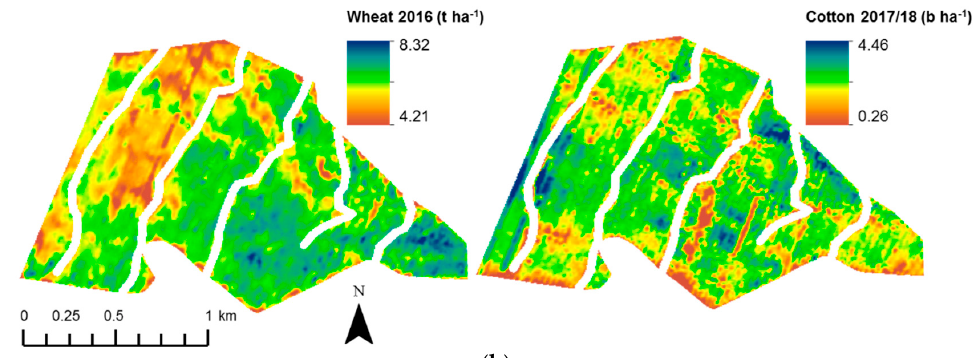
Figure 4. ( a ), Canola yield for the 2016 season (left), and chickpea yield for the 2017 season (right) from a yield monitor for field Campey 4/5 (C4/5). ( b ), Wheat yield for the 2016 season (left), and cotton yield for the 2017/18 season (right) from a yield monitor for field L’lara 2 (L2).